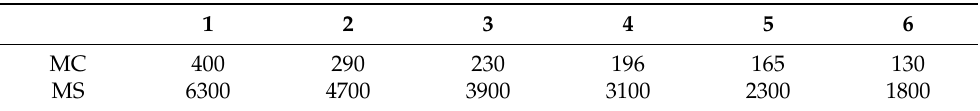
Table 1. Diameters of the microcalcifications (MC) and of the masses (MS) in the BR3D phantom as reported in [42]. Measures are in micrometers ( µ